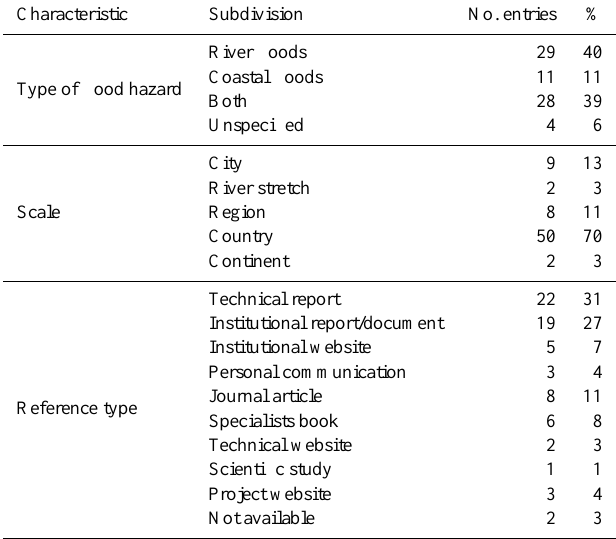
Table 1. Overview of the characteristics of information contained in the design layer of the FLOPROS database (the full database is available in the Supplement).